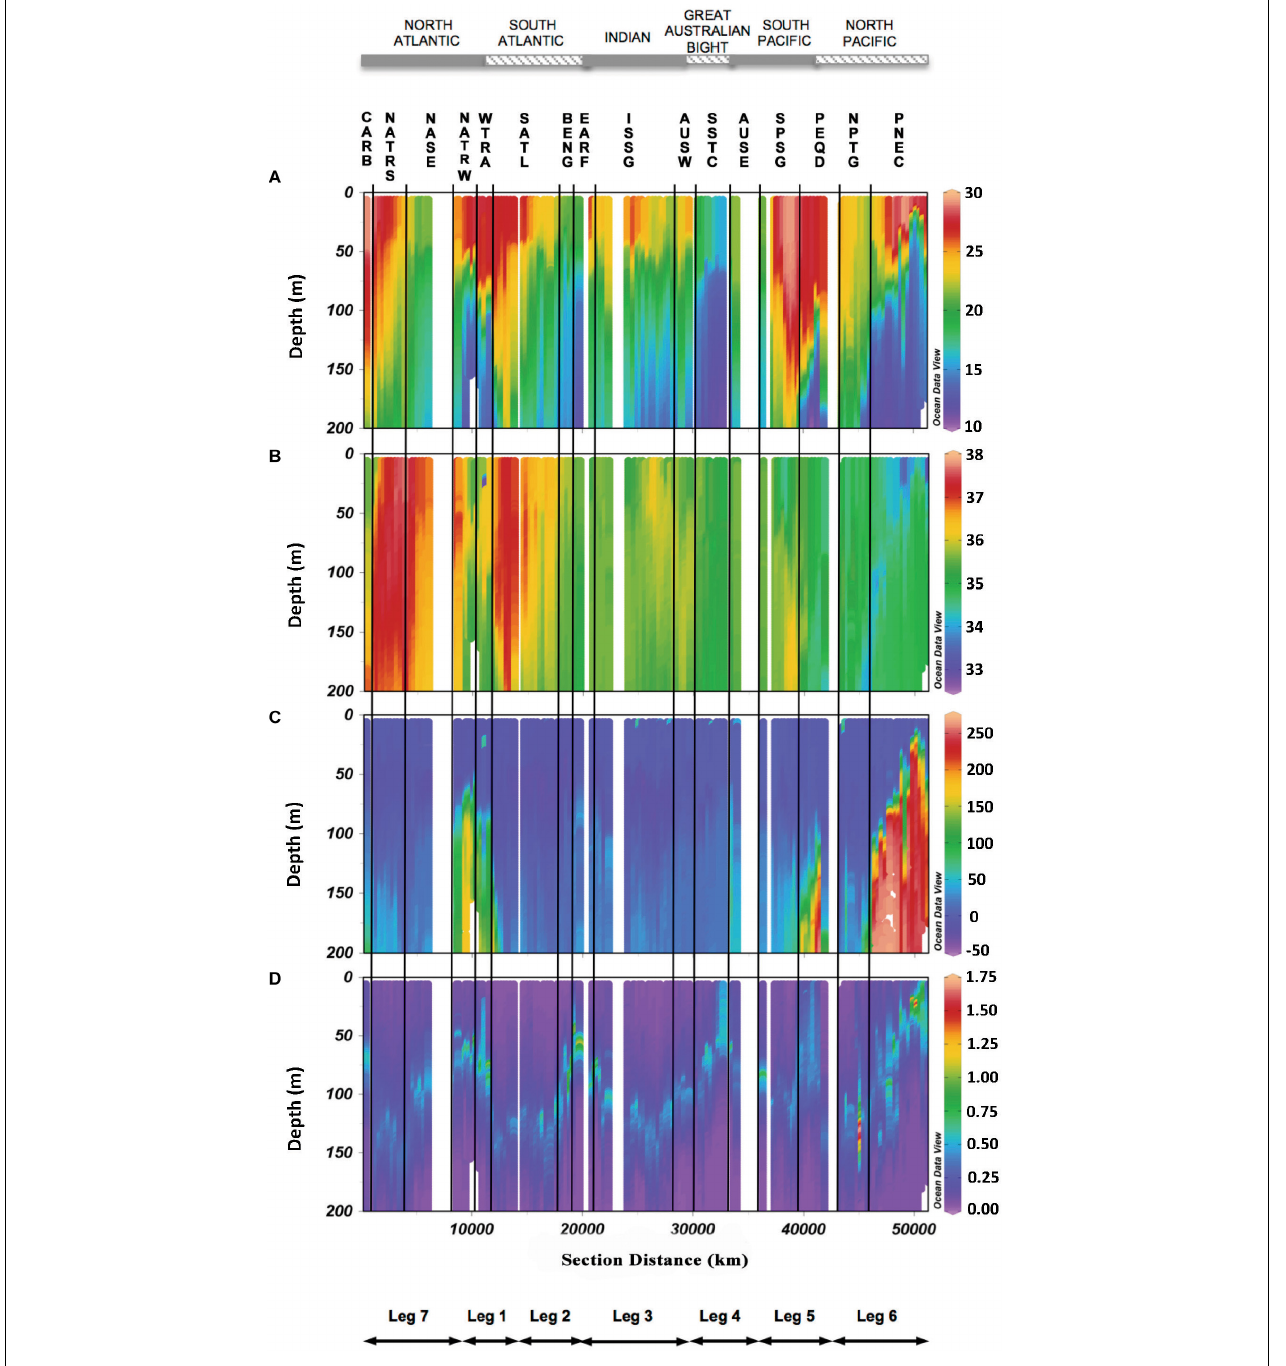
FIGURE 2 | Vertical depth profiles of hydrographic CTD continuum parameters among the biogeographic provinces crossed during the circumnavigation (see caption of Figure 1 for acronyms): (A) potential temperature θ ( ◦ C), (B) Salinity (S), (C) Apparent oxygen utilization (AOU) ( µ mol kg − 1 ), and (D) Chlorophyll a (Chl a ) (mg m − 3